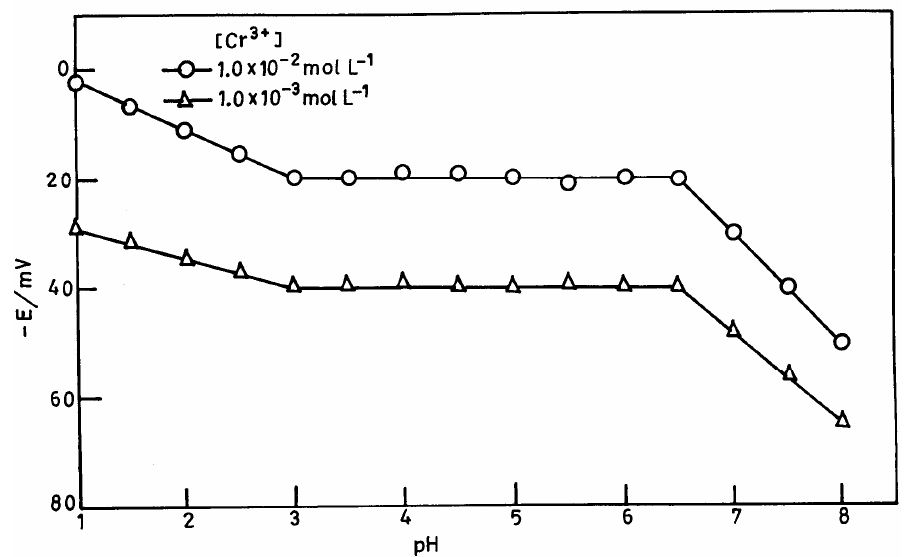
Figure 2. The variation of membrane potential with pH at 1.0x10 -2 mol L -1 and 1.0x10 -3 mol L -1 Cr 3+